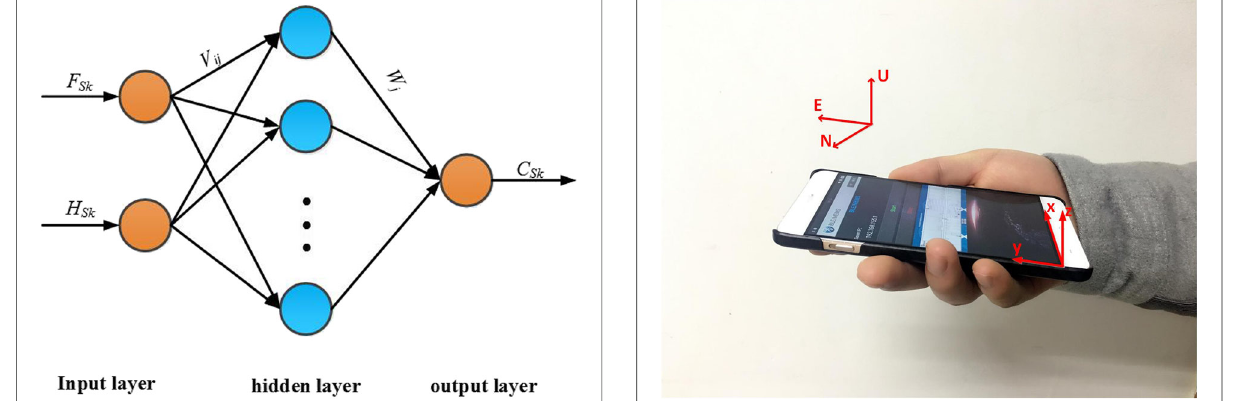
Fig. 9 Geographic reference coordinate